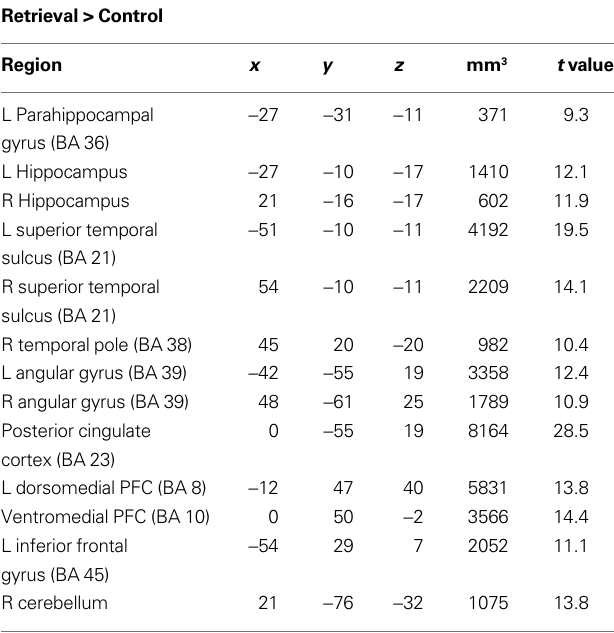
Table 1 | Regions comprising the ‘retrieval network’